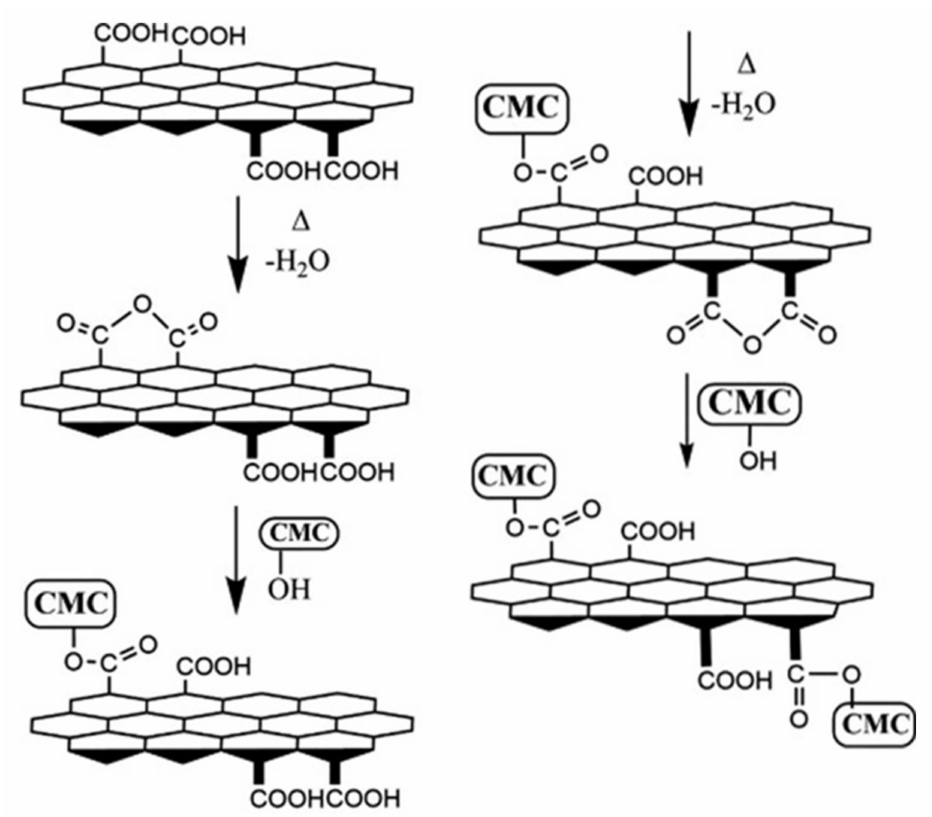
Figure 7. Schematic illustration of the proposed formation mechanism for CMC / GQDs hydrogels [104]. Reproduced with copyright